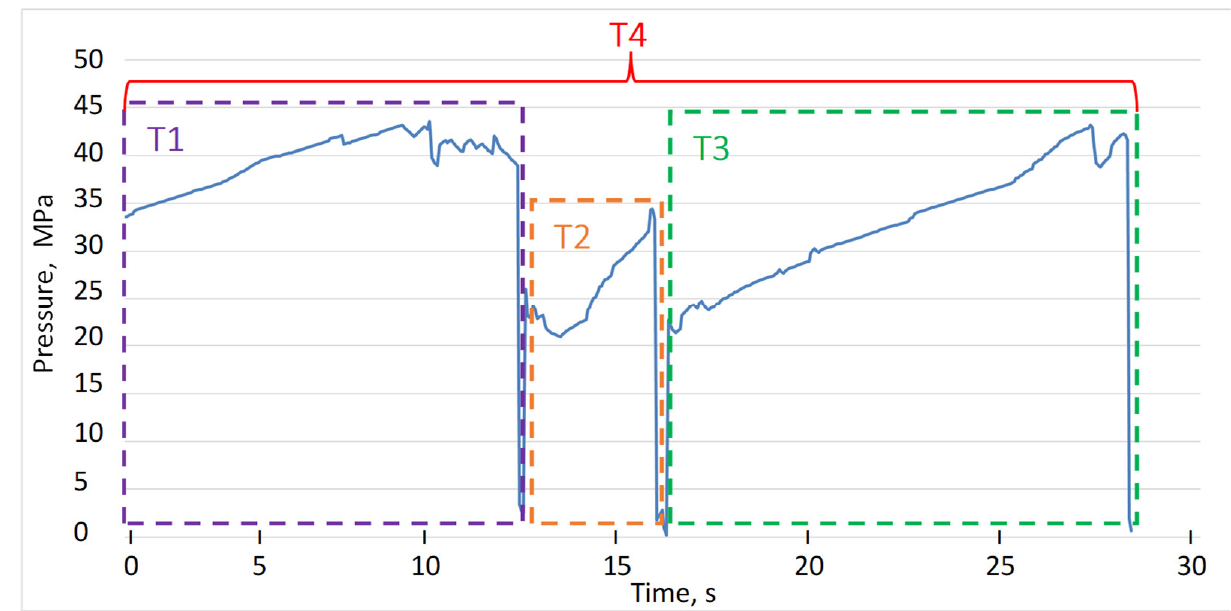
Figure 3. Recorded pressure during the rock mass shock that caused the rack to